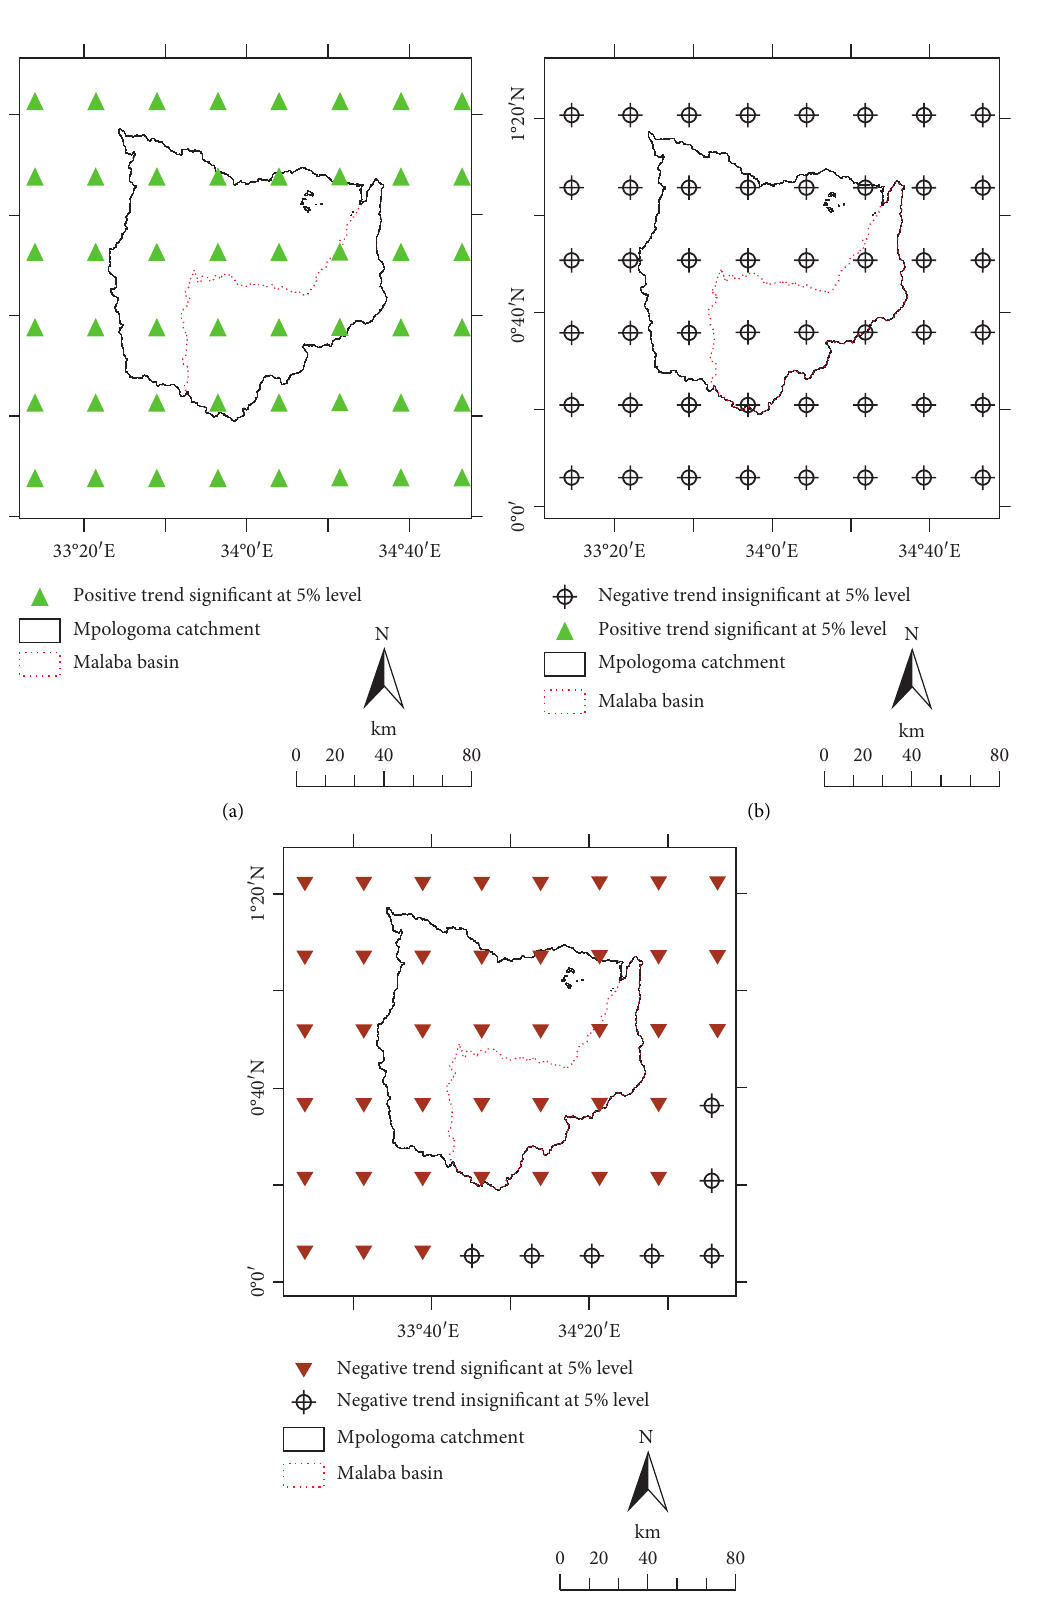
Figure 2: Trend on rainfall: (a) annual/MAM, (b) OND, and (c)